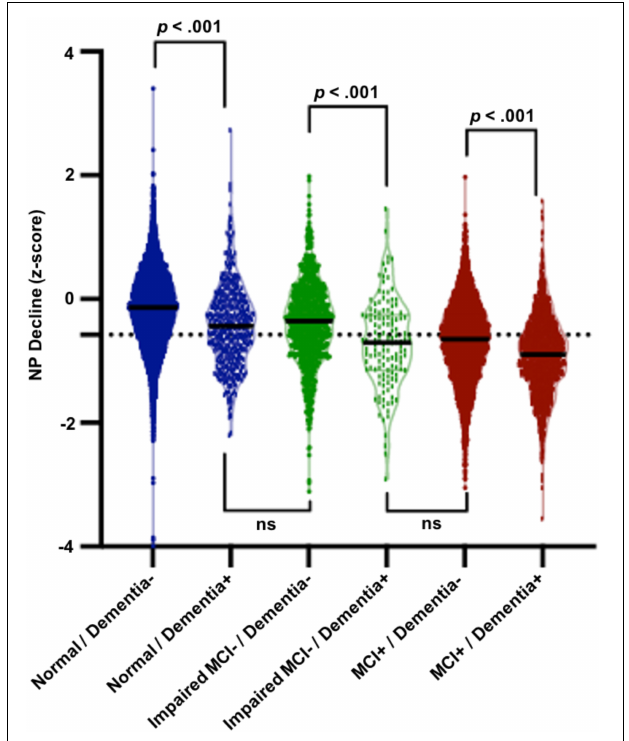
FIGURE 1 | Results of 2 × 2 ANCOVA (baseline clinical diagnosis × dementia outcome). Cognitively normal older adults who ultimately developed dementia exhibited significantly worse NP decline (M = –0.46, SD = 0.57, range = 3.32) than those who did not develop dementia (M = –0.14, SD = 0.59, range = 3.98, p < 0.001) and did not significantly differ in NP decline from those who were impaired without MCI. Similarly, impaired without MCI participants who progressed to dementia displayed worse NP decline (M = –0.58, SD = 0.60, range = 2.55) than those who did not progress to dementia (M = –0.31, SD = 0.64, range = 2.50, p < 0.001) and did not significantly differ from those who were diagnosed with MCI. Finally, MCI participants who progressed to dementia exhibited significantly greater NP decline (M = –0.79, SD = 0.58, range = 2.59) than those who did not progress to dementia (M = –0.58, SD = 0.63, range = 2.35, p <